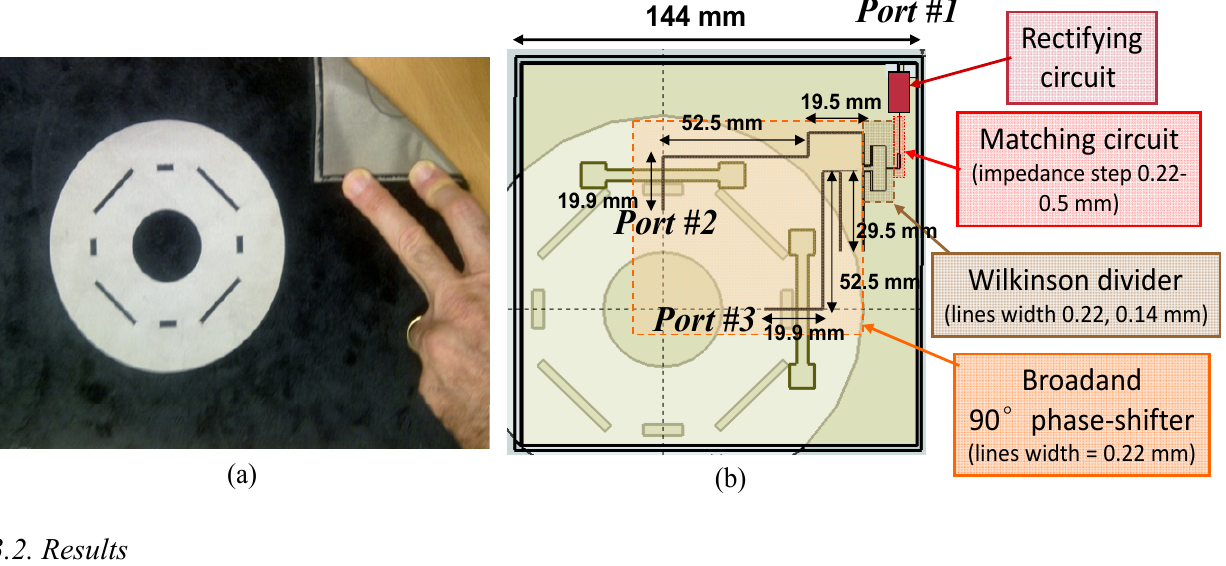
Figure 6. ( a ) Photo of the multi-layered rectenna prototype. ( b ) Layout of the three-port feeding network; Port 1 is in DC, while Port 2 and Port 3 are the RF antenna feeding ports needed for ensuring circular polarization.